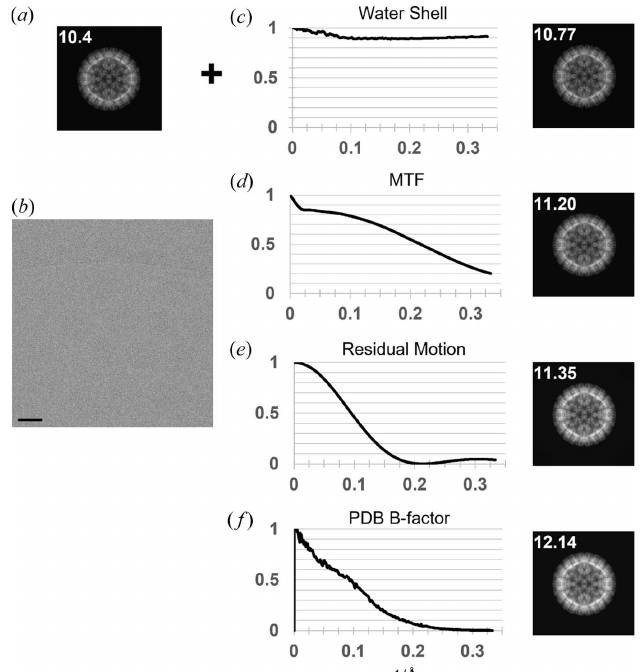
Figure 6 ( a ) Projection of simulated rotavirus DLP, using PDB entry 3gzu, with the average peak SNR mf from 180 DLPs overlaid in white. ( b ) Example image from movie frame two, with only 1.5 e (cid:2) A˚ (cid:2) 2 cumulative exposure. ( c ) Ratio of the rotationally averaged power spectrum of a simulation with solvent embedding to the base simulation as in ( a ). ( d ) Ratio of the rotationally averaged power spectrum of a simulation with solvent embedding and detector MTF to the previous simulation as in ( c ). ( e ) Ratio of the rotationally averaged power spectrum of a simulation with solvent embedding, detector MTFand residual intra-frame motion blur to the previous simulation as in ( d ). ( f ) Ratio of the rotationally averaged power spectrum of a simulation with solvent embedding, detector MTF, residual intra-frame motion blur and PDB B -factors to the previous simulation as in ( e ). Scale bar 500 A˚